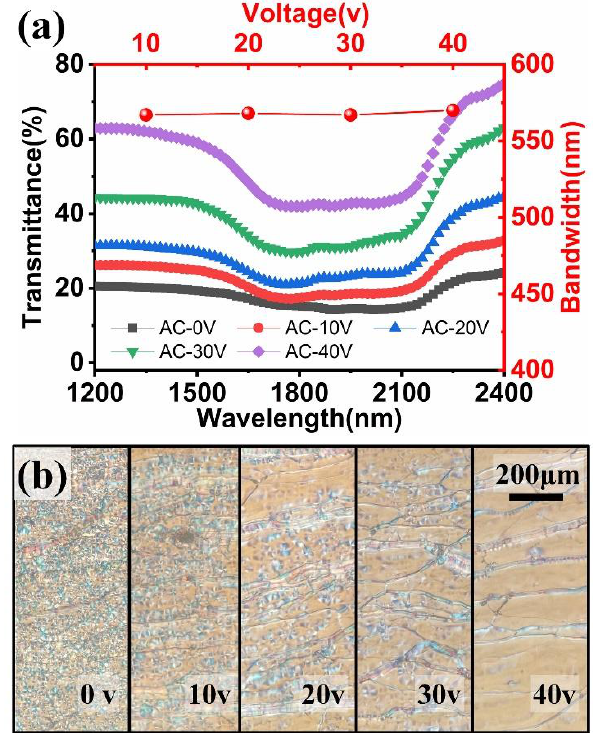
Figure 5. Influence of AC voltage intensity on ( a ) UV transmission spectra and ( b ) LC texture of focal cone state in LC sample 1.